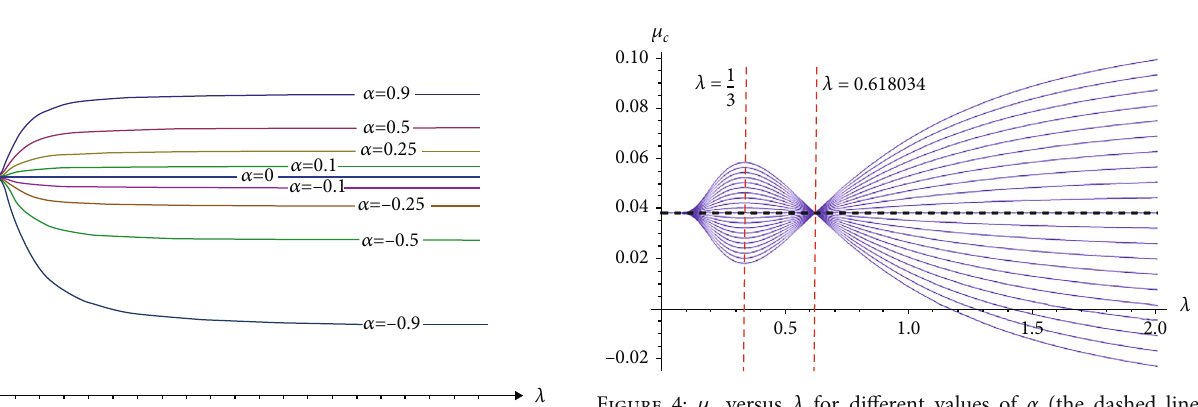
Figure 2: Triangular equilibria L